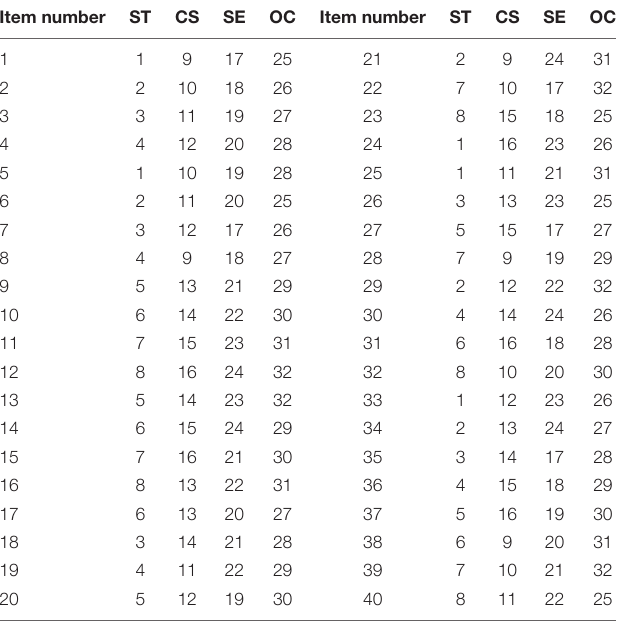
TABLE 1 | Statement numbers in the online value test with compositional